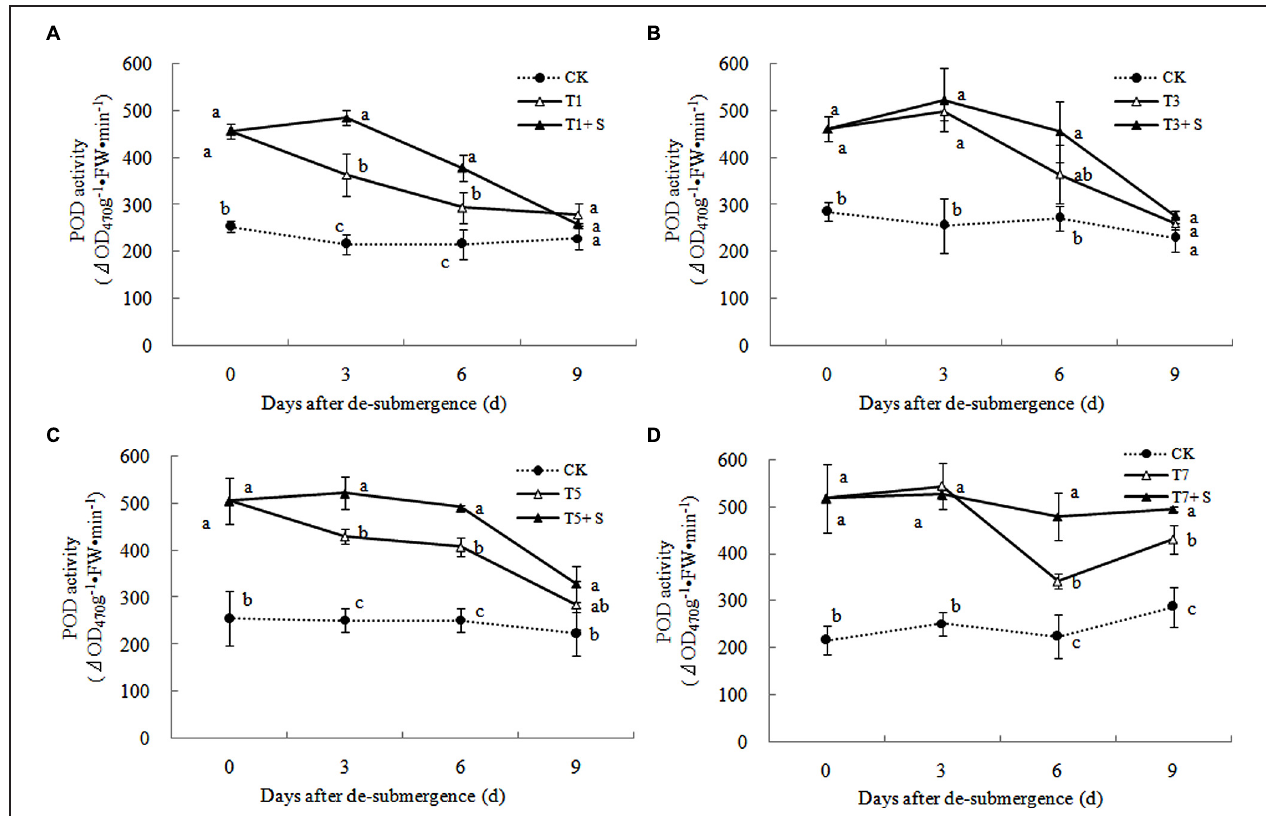
FIGURE 11 | Effects of Spd on peroxidase (POD) activity of rice after submergence.